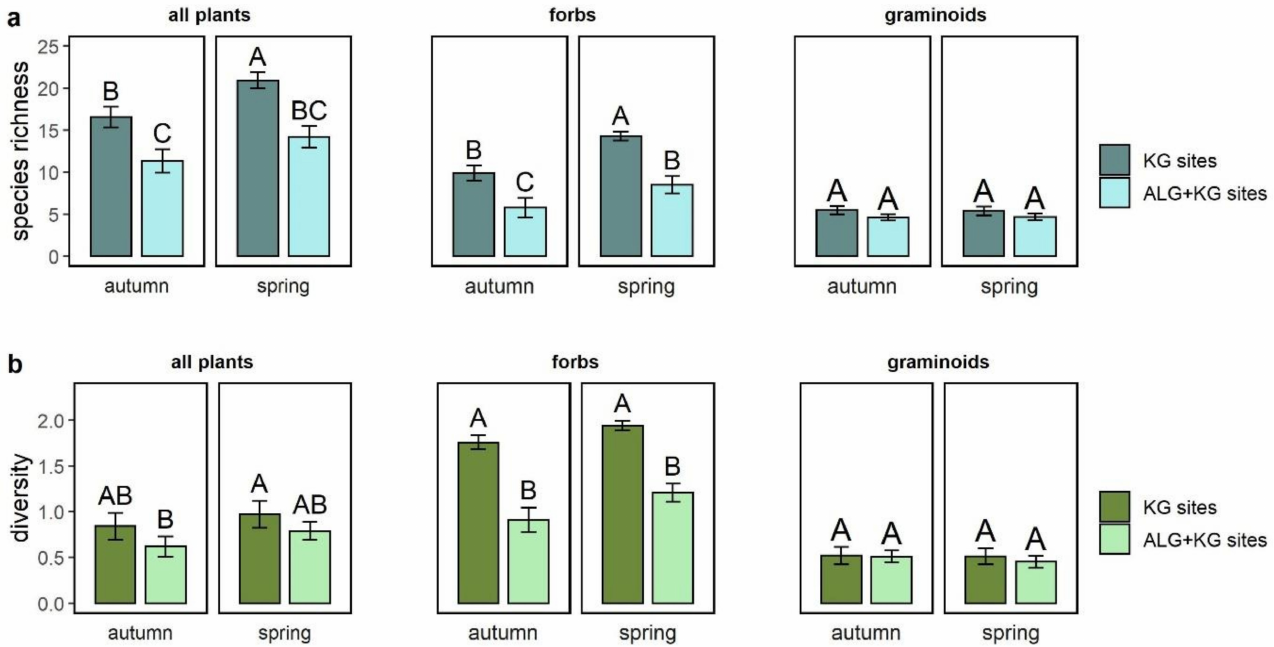
Figure 1. ( a ) Mean species richness and ( b ) Shannon diversity per plot for all plants (left), only forbs (middle), and only graminoids (right) on KG (darker colour) versus ALG+KG (lighter colour) sites. Different capital letters indicate significant differences ( p < 0.05) among site types and sampling season. Error bars represent the standard error of the